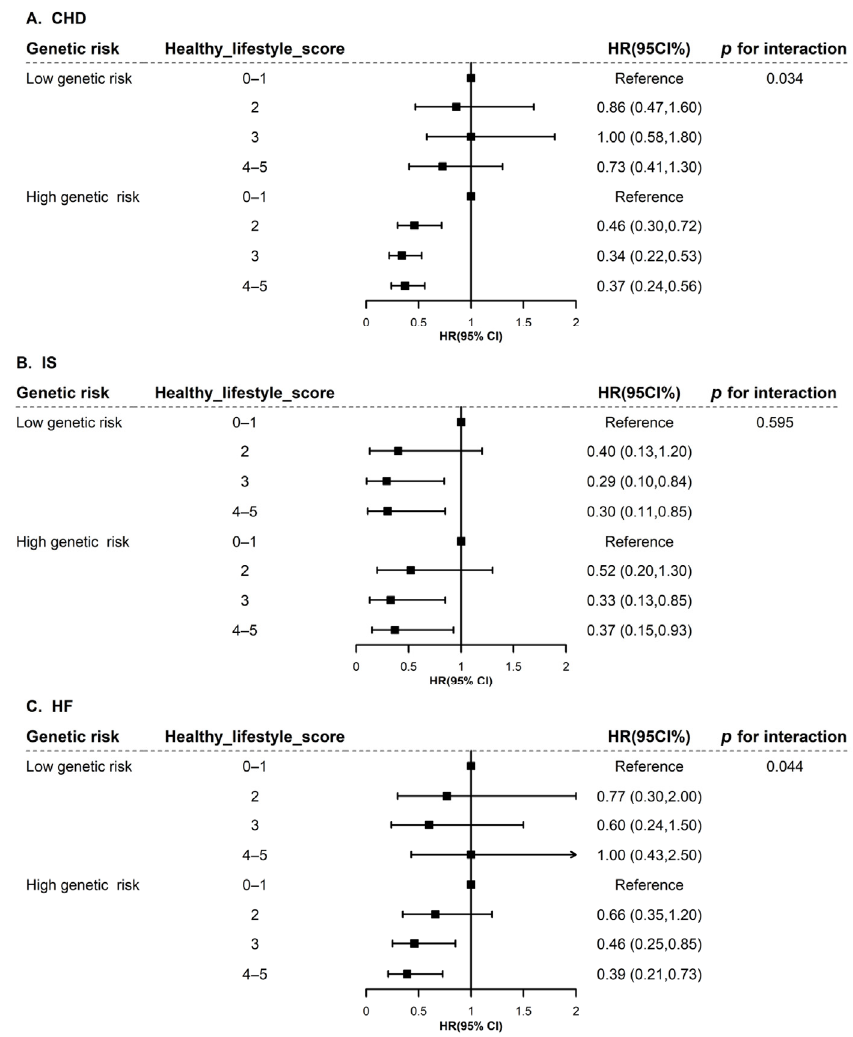
Figure 2. Subgroup analysis of healthy lifestyle score with CHD ( A ), IS ( B ), and HF ( C ) among fe- males with breast cancer stratified by genetic risk. CHD, coronary heart disease; IS, ischemic stroke; HF, heart failure; CI, confidence interval. Genetic risk is classified as low risk or high risk based on median. We investigated the association of healthy lifestyle factors with CHD, IS, and HF stratified by genetic risk. The model was adjusted for age at diagnosis of breast cancer, race (white European, others), the Townsend Deprivation Index (continuous), diabetes (yes/no), hypertension (yes/no), antihypertensive drugs (yes/no), insulin treatment (yes/no), lipid treatments (yes/no), HRT (yes/no), menopause (yes/no), surgical treatment of breast cancer (yes/no), genotyping batch, and the first 10 genetic principal components.